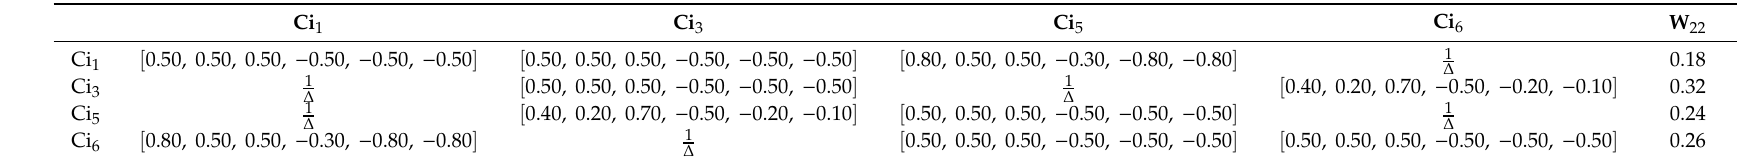
Table 13. Interior interdependencies matrix of factor C 8 .